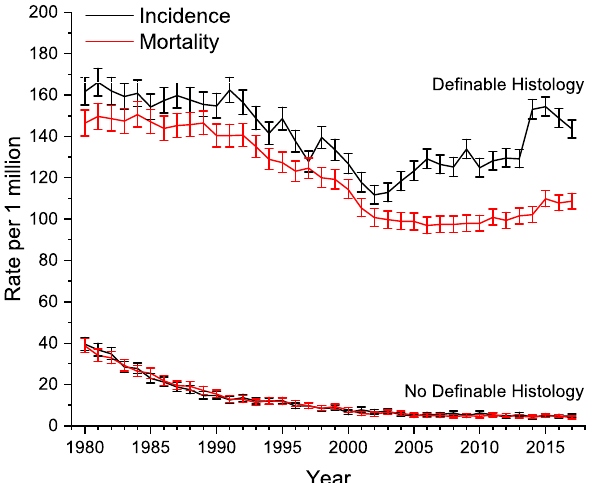
Figure 2. Age-adjusted yearly incidence and mortality rates for undifferentiated carcinomas. Definable histology refers to undifferentiated carcinomas with an ascribed histology, and no definable histology refers to undifferentiated carcinomas without an ascribed histology. Error bars represent 95% confidence intervals.